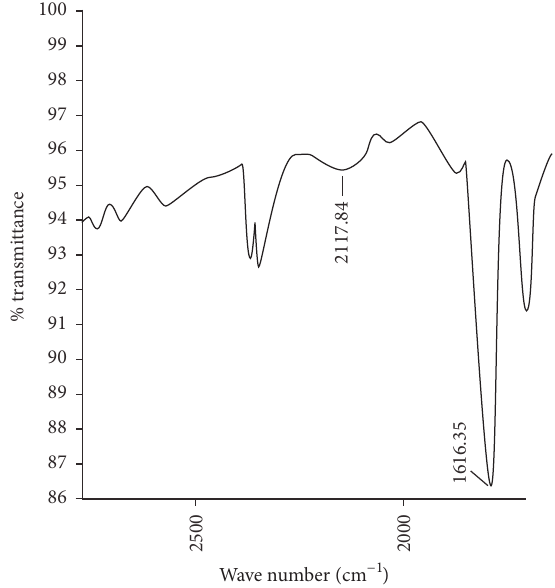
Figure 6: IR spectra of nano- [ Fe III ( Pc )( SCN )] 𝑛 .